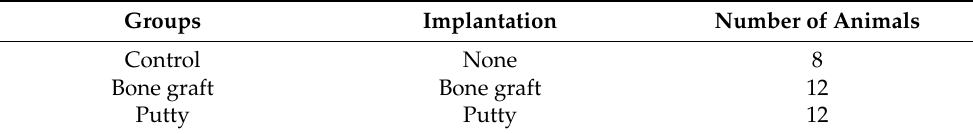
Table 1. Animal groups and implantation details in rabbit femoral bone defect model. Groups Implantation Number of Animals Control None 8 Bone graft Bone graft 12 Putty Putty